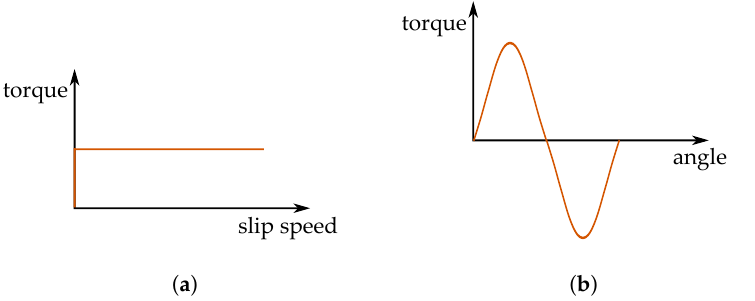
Figure 12. Torque characteristics of hysteresis torque limiter ( a ) vs. slip speed and ( b ) vs. electrical angle at synchronous speed (i.e., zero slip